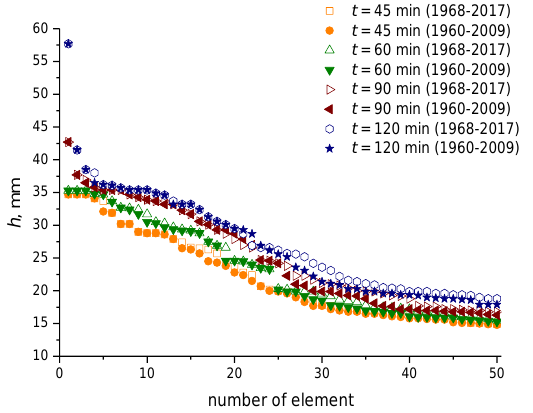
Fig. 2. Comparison 45, 60, 90 and 120 minutes duration rainfall in the periods 1960–2009 and 1968–2017.